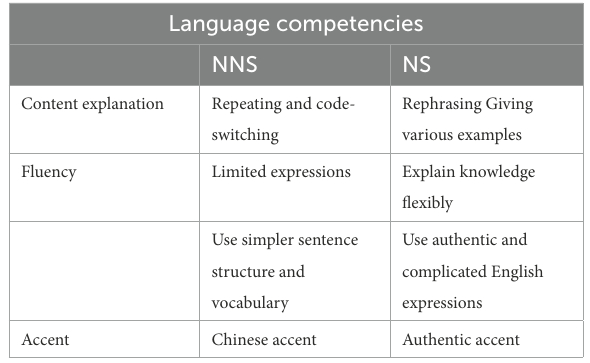
TABLE 2 EMI lecturers’ language